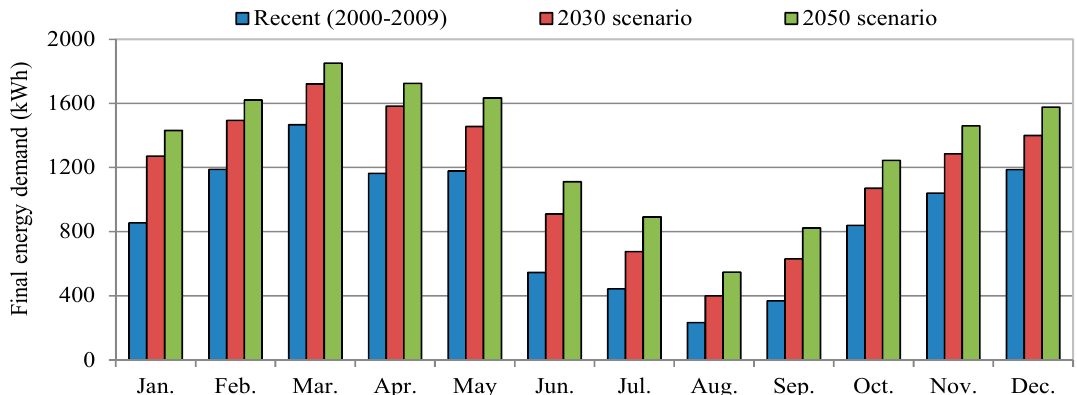
Figure 5. Monthly cooling energy demands for the building under recent and projected future climates.